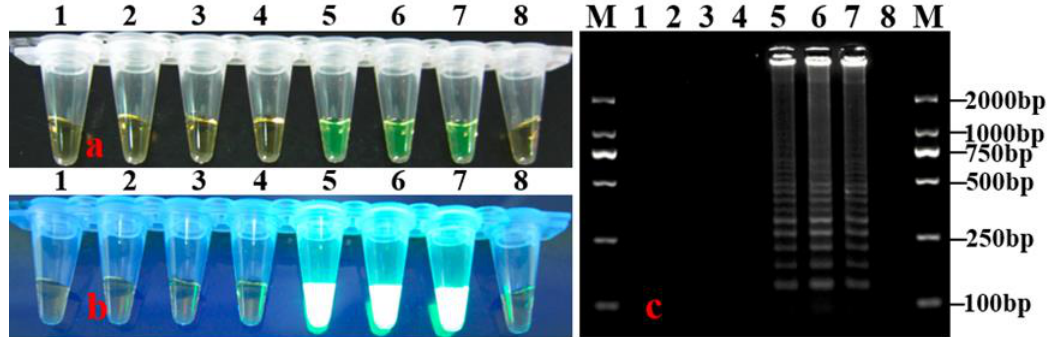
Figure 2. Optimization of LAMP reaction temperature for detection of M. acerina . ( a ) LAMP products were visualized by naked eye under natural light (color change, yellow-green indicate positive reaction). ( b ) LAMP products were visualized by naked eye under UV light (bright white turbidity indicates positive reaction). ( c ) LAMP products were analyzed using electrophoresis on 2% agarose gel (ladder-like pattern bands indicate positive reaction). Lane 1: negative control (SDW); Lane 2: 62.5 °C; Lane 3: 63 °C; Lane 4: 63.5 °C; Lane 5: 64 °C; Lane 6: 64.5 °C; Lane 7: 65 °C; Lane 8: 65.5 °C; Lane M: DL 2000 DNA marker. The color of tubes 5 – 7 is yellow-green.